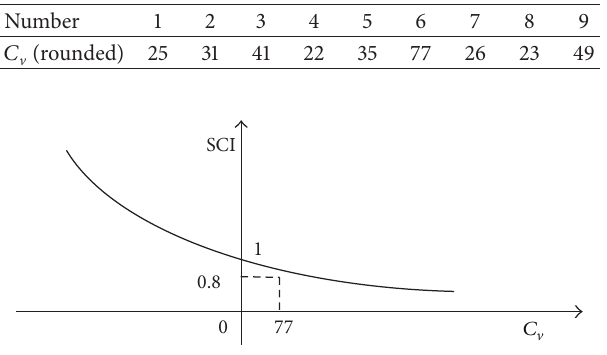
Table 3: Safety level of pedestrians.